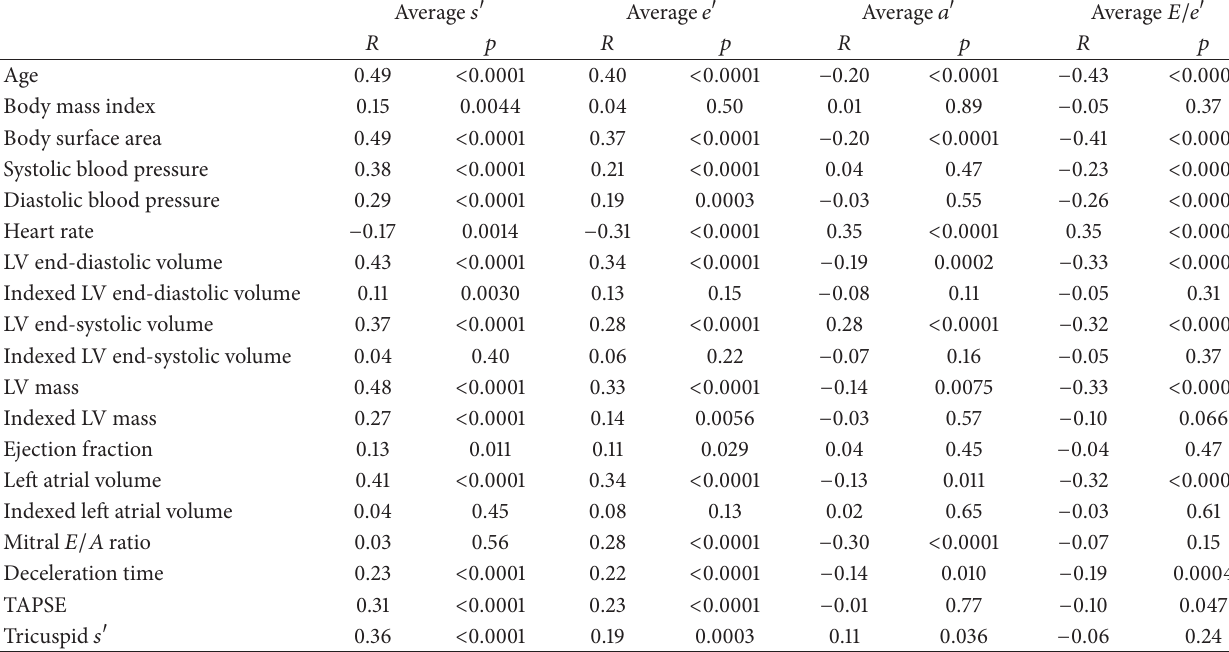
Table 2: Univariable relationships of tissue Doppler indexes with clinical and echocardiographic variables in the study population. Values were computed by considering the average of velocities taken at the septal and lateral site.